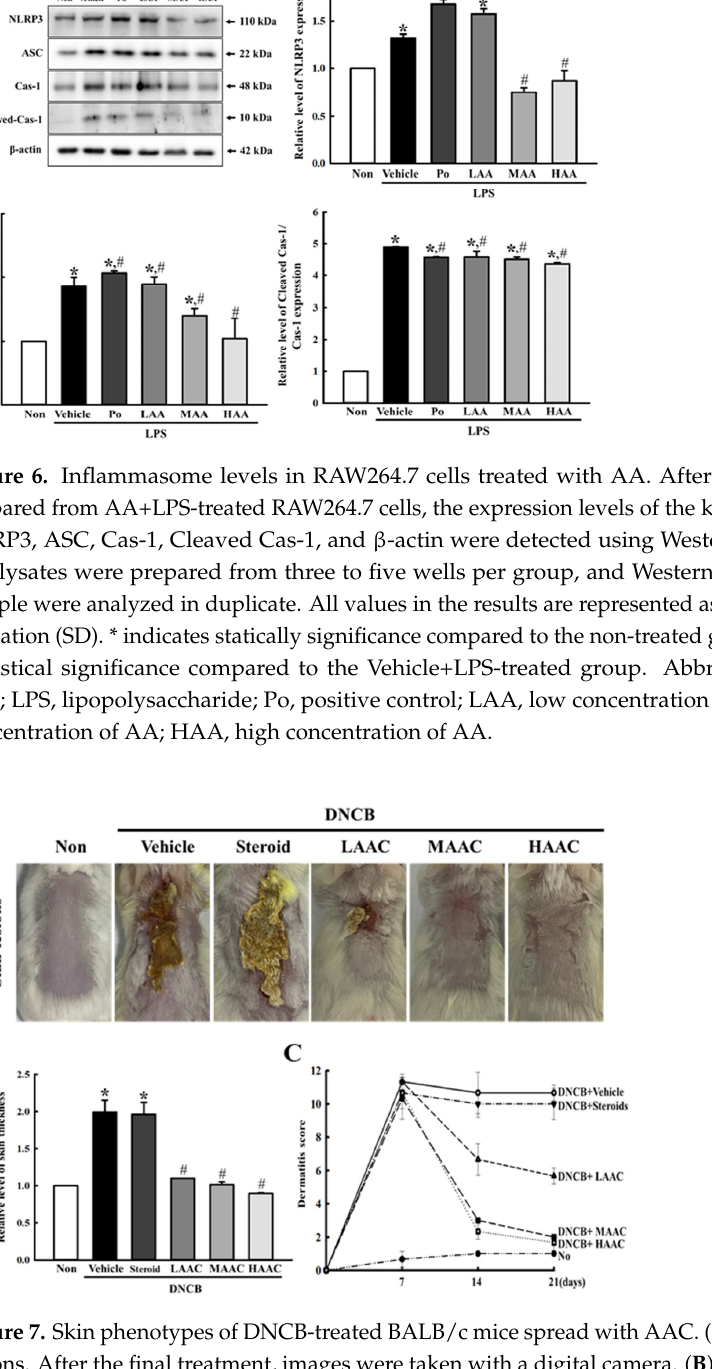
Figure 6. Inflammasome levels in RAW264.7 cells treated with AA. After total cell lysates were pre- pared from AA+LPS-treated RAW264.7 cells, the expression levels of the key regulators including